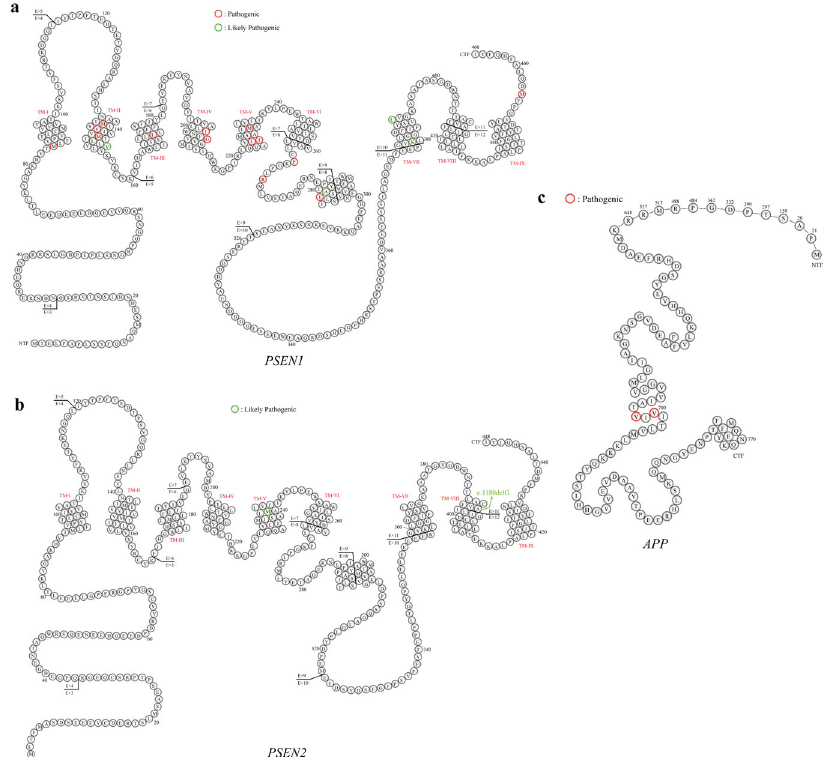
Fig. 2 Distribution of amino acid substitutions in the PSEN1, PSEN2, and APP proteins. Red circles: pathogenic mutations identi fi ed. Green circles: likely pathogenic mutations identi fi ed. A Ala, C Cys, D Asp, E Glu, F Phe, G Gly, H His, I Ile, K Lys, L Leu, M Met, N Asn, P Pro, Q Gln, R Arg, S Ser, T Thr, V Val, W Trp, Y Tyr, APP amyloid precursor protein, PSEN presenilin. a The distribution of PSEN1 P/LP variants. b The distribution of PSEN2 P/LP variants. c The distribution of APP P/LP